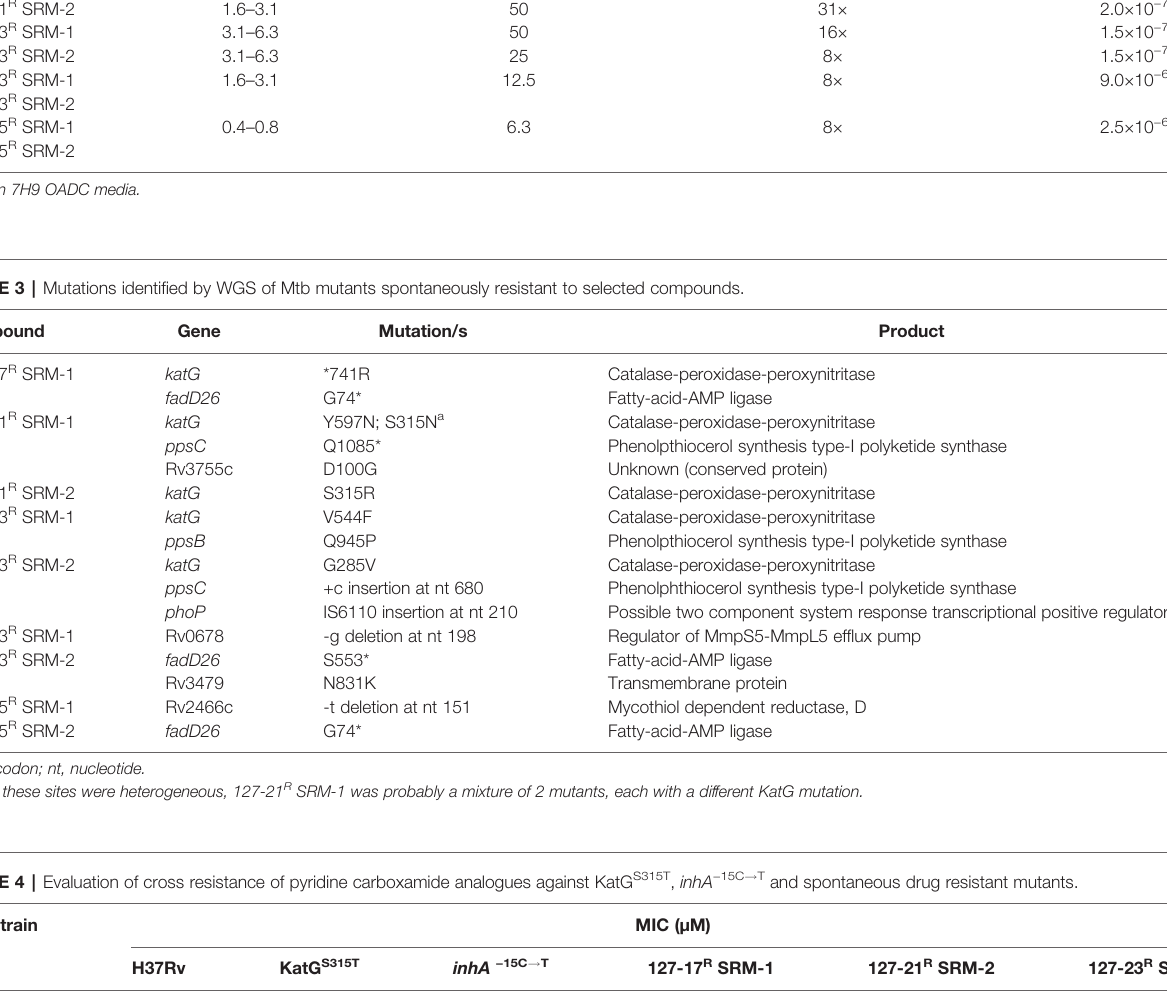
TABLE 2 | Drug resistant mutants isolated against selected compounds. Compound MIC against H37Rv (µM)